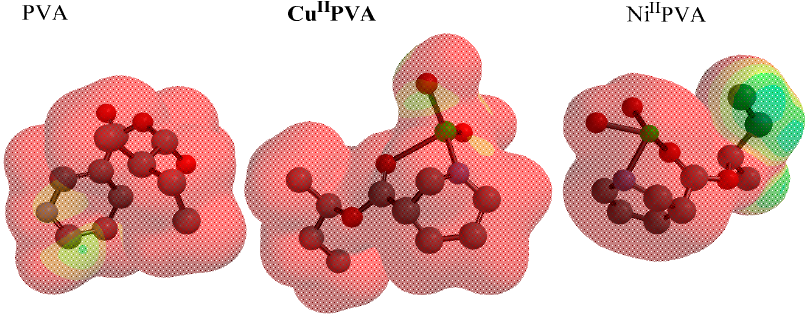
Figure 10. Electrostatic potential for PVE, Ni/PVA-NA and Cu/PVA-NA at DFT/BY3LP. (iii)The Local Reactivity profile: